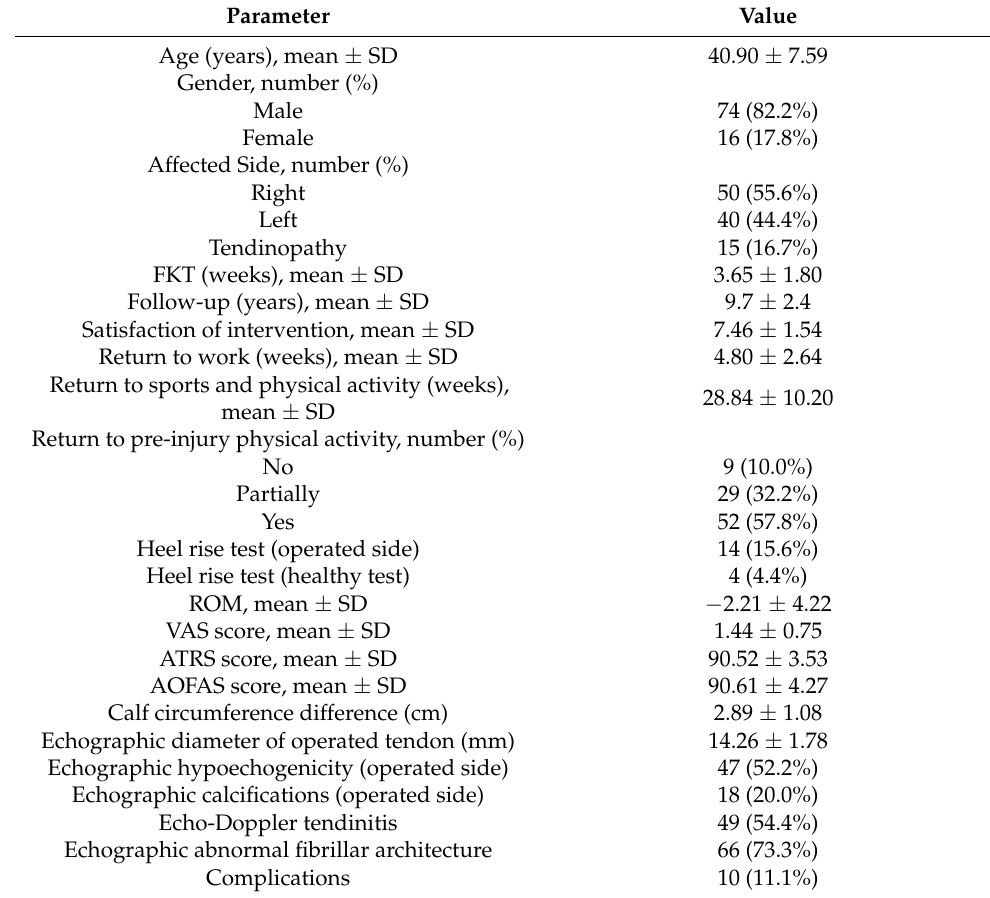
Table 1. Demographics, clinical outcomes of the cohort ( n =